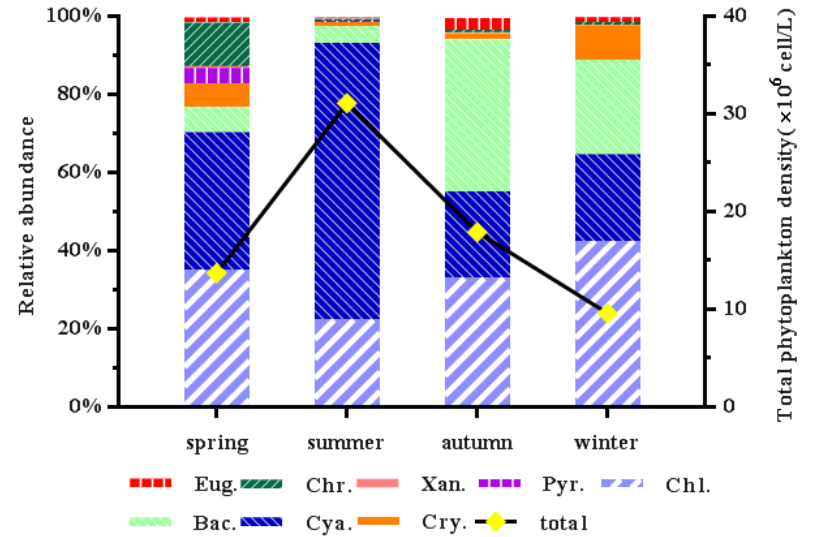
Figure 3. Total phytoplankton cell density and relative abundance (×10 6 cell/L) in Shengjin Lake.